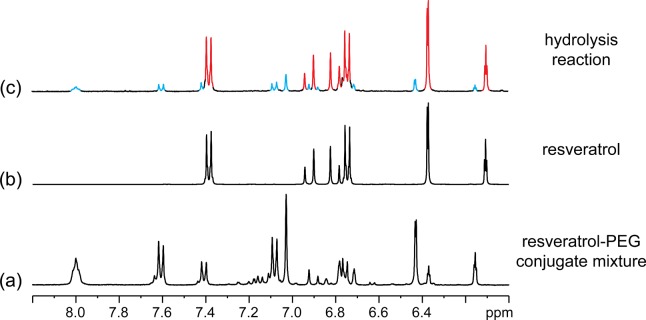
The down field region of 1H NMR spectra (400 MHz) for: (a) a solution of the MeO-PEGN-Succ-RSV (2 kDa) conjugate mixture in d
6-DMSO; (b) a solution of resveratrol in d
6-DMSO; and (c) the solution from (a) after treatment with water and heat (90°C) for ca. 1 week).In (c) the signals for free resveratrol are highlighted in red and those for the remaining resveratrol-PEG conjugates are highlighted in blue. Full width versions of these spectra are provided in S1 File, along with a comparison with the MeO-PEG-Succ-OH starting material.